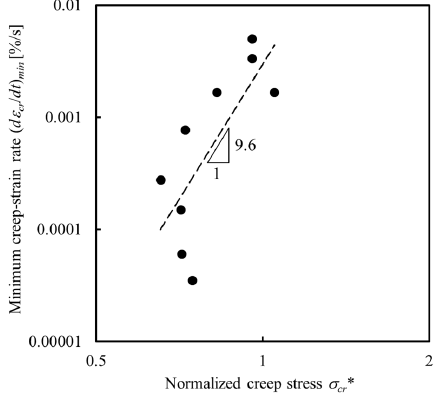
Figure 9. Minimum creep-strain rate ( d ε cr / dt ) min versus normalized creep stress σ cr